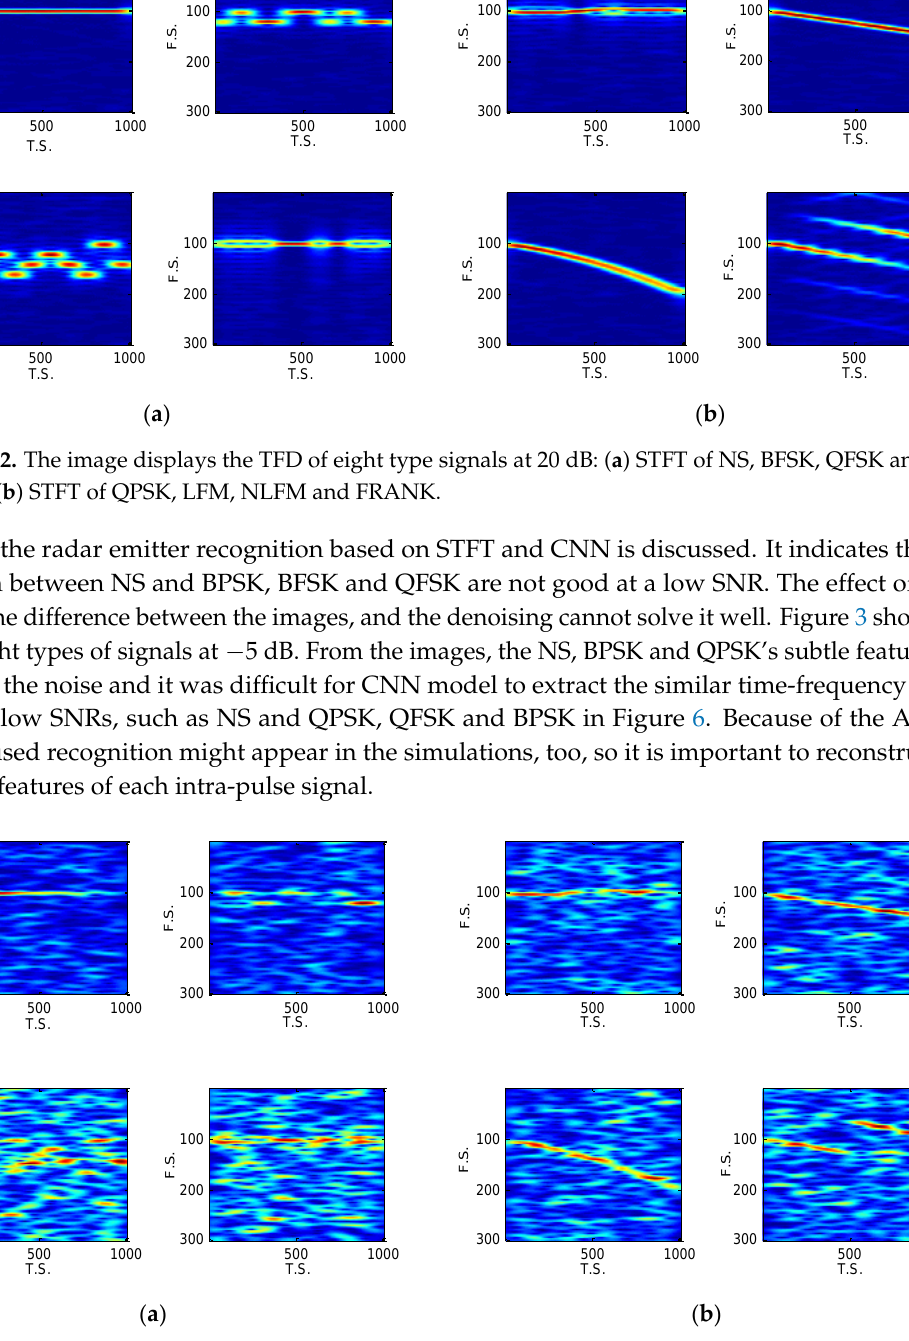
Figure 3. The TFD of eight types of signals at − 5 dB: ( a ) STFT of NS, BFSK, QFSK and BPSK; ( b ) STFT of QPSK, LFM, NLFM and FRANK.